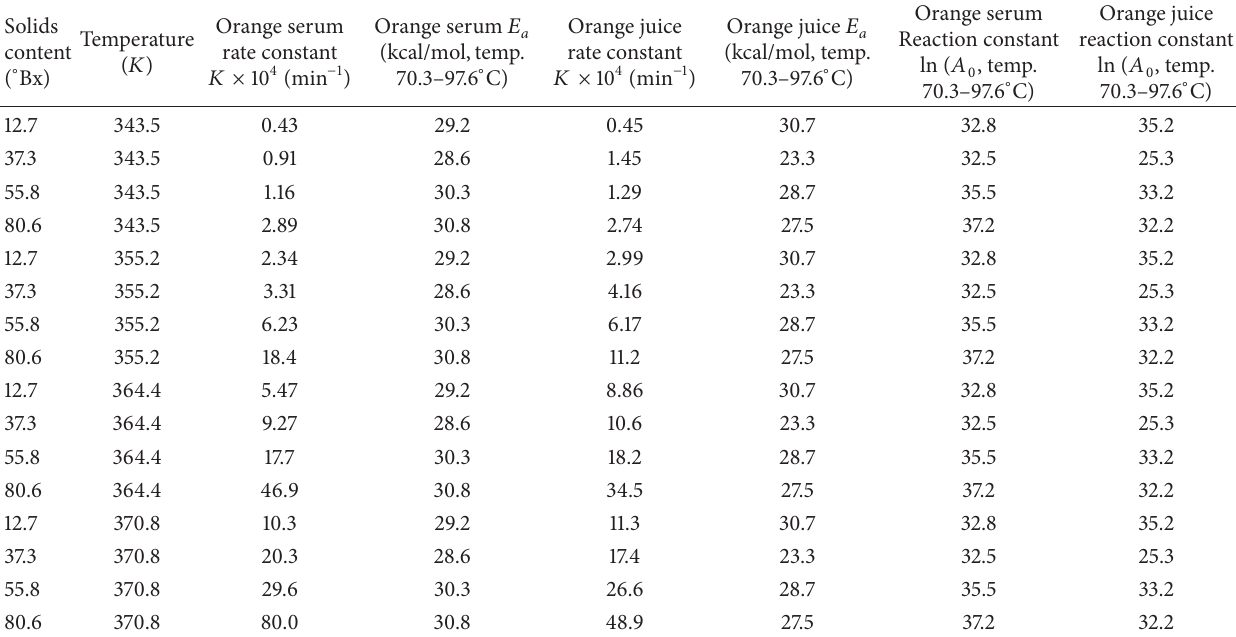
Table 10: Effect of temperature and solids content on anaerobic degradation of ascorbic acid in orange serum and in whole orange juice. Adapted from